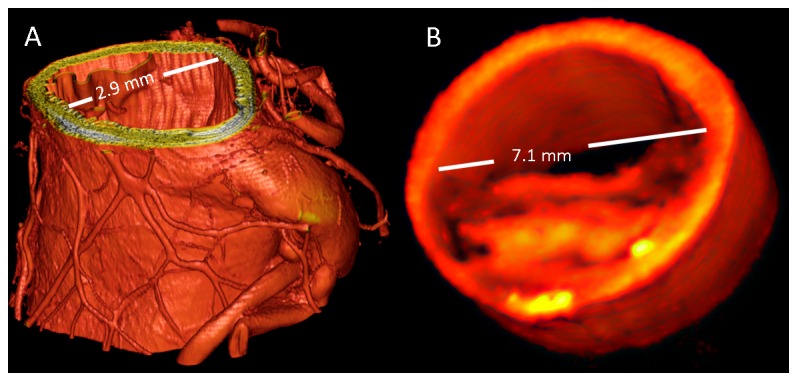
Three-dimensional renderings of the phase contrast tomographic data sets.(A) Near-normal carotid artery imaged at the synchrotron beamline ID19, ESRF, France. Due to the high resolution of the images and the excellent soft tissue contrast, several vasa vasorum can be identified without the use of contrast dye. (B) Atherosclerotic lesion imaged at the laboratory (Images were rendered using VGStudioMax 2.1, Volume Graphics, Heidelberg, Germany)..